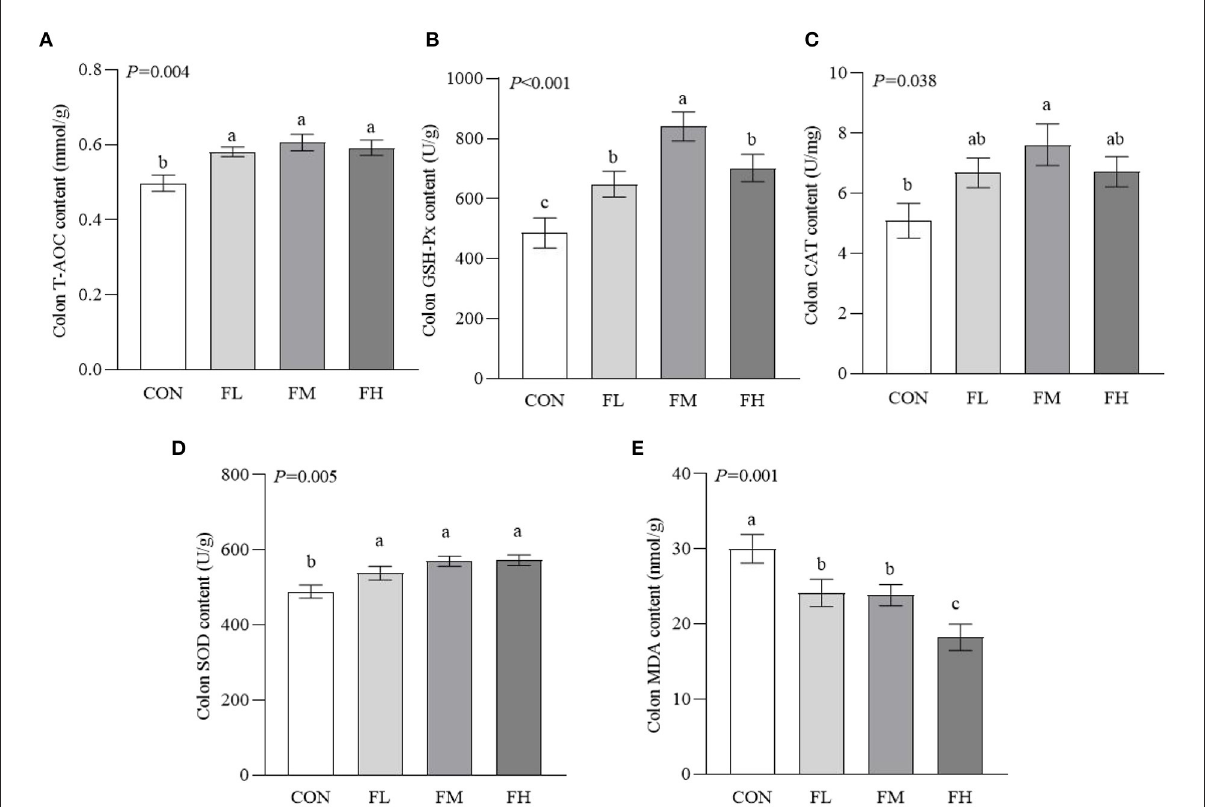
FIGURE4 Effects of fucoidan on the colon antioxidant indexes of weaned lambs. (A) T-AOC. (B) GSH-Px. (C) CAT. (D) SOD. (E) MDA. CON, control; FL, 0.1% fucoidan (DMI); FM, 0.3% fucoidan (DMI); FH, 0.6% fucoidan (DMI). Data are denoted as mean ± SEM ( n = 3). a,b,c Demonstrate a statistically significant distinction, P < 0.05.